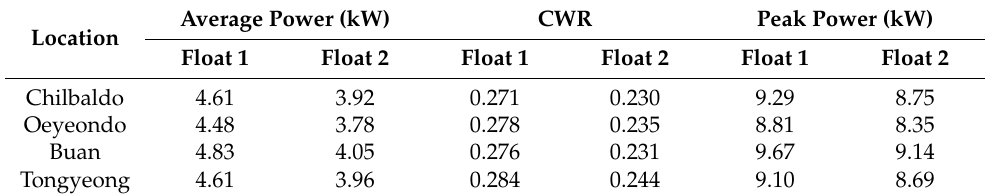
Table 5. Average power, CWR, and peak power at each location with a 0 ◦ wave direction. Average Power (kW) CWR Peak Power (kW) Location Float 1 Float 2 Float 1 Float 2 Float 1 Float 2